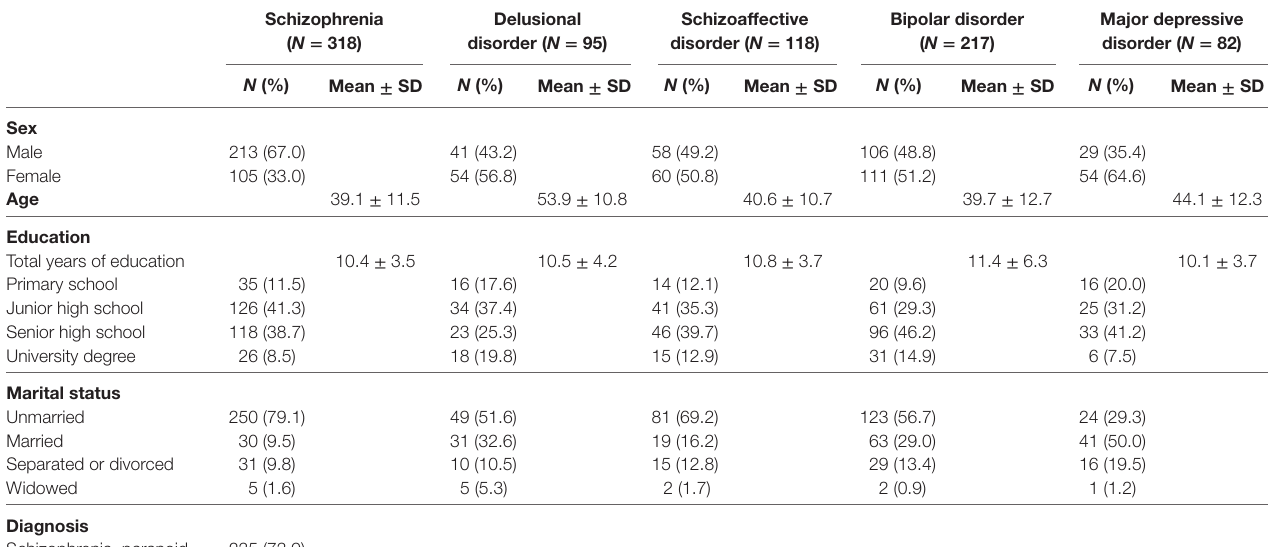
Table 1 | Patient